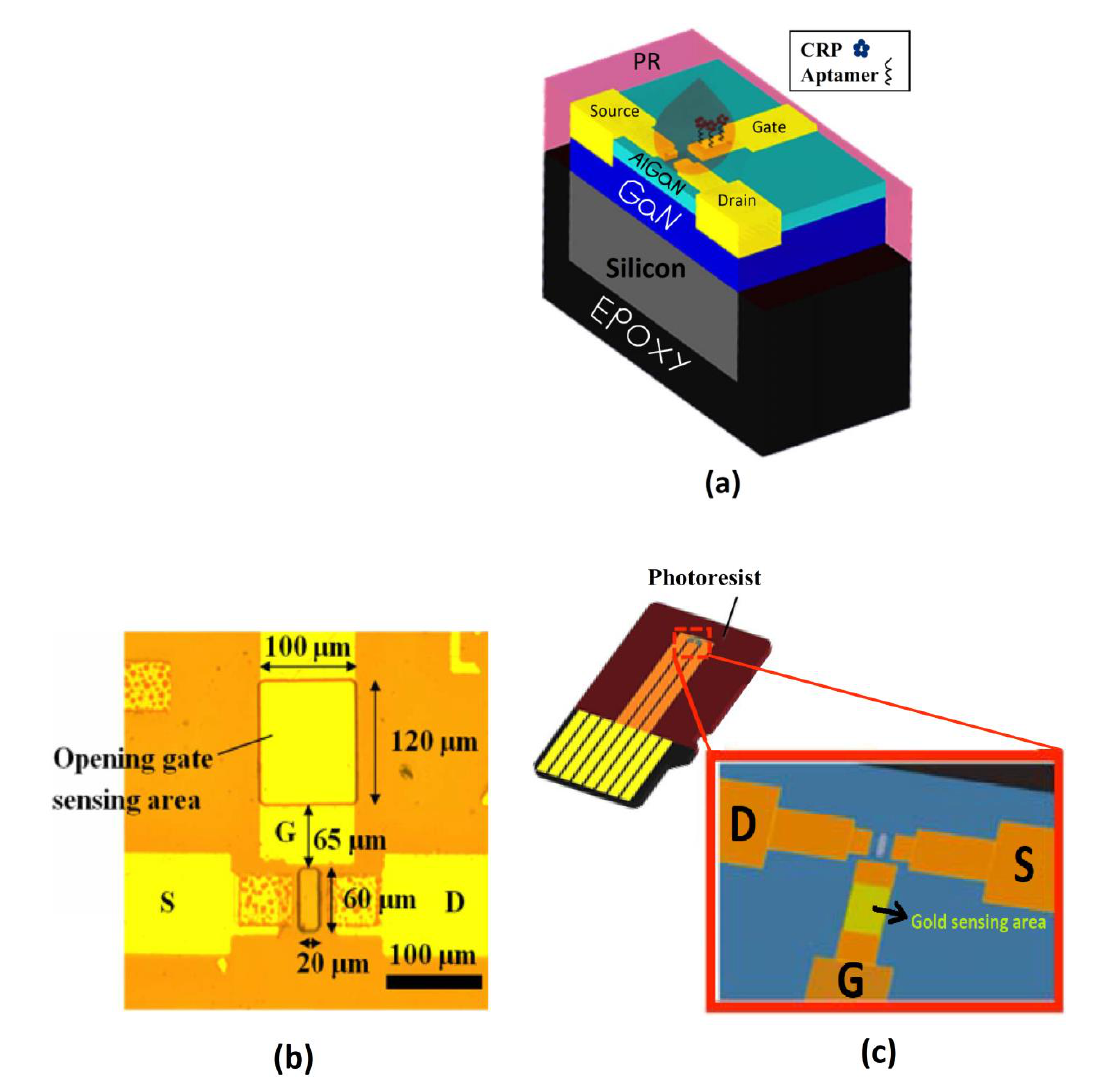
Figure 10. ( a ) Schematic sketch of GaN/AlGaN HEMT . ( b ) Top view of the device showing sensing region consisting of channel opening (20 × 60 µ m 2 ) and extended gate electrode opening (100 × 120 µ m 2 ); the distance between the transistor channel and gate electrode is 65 µ m. ( c ) Showcasing of the device from the fabricated chip. Reproduced from [28] under the terms of Creative Commons Attribution Non-Commercial No Derivatives 4.0 License.